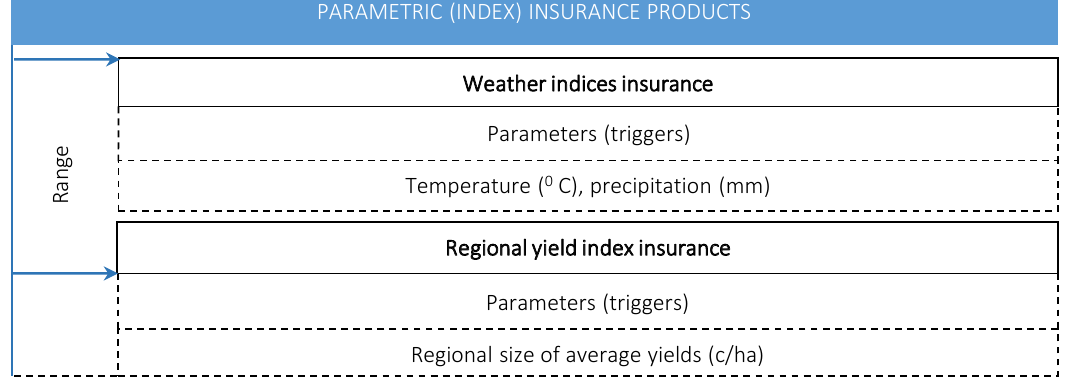
Figure 12. Set of parametric (index) insurance products used in agrarian enterprises of Ukraine in